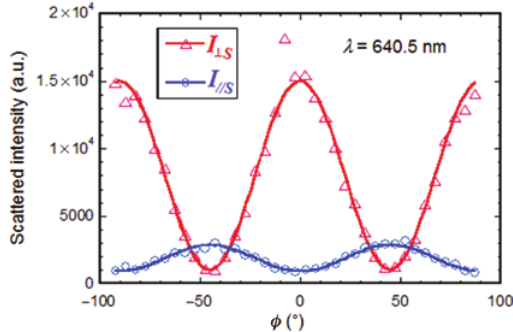
Figure 5: Example shown at l = 640.5 nm of the signal scattered by sample S3-C along the two output polarization channels I perpendicular and parallel to the scattering plane, respectively. Solid lines are a fit to cos 2 φ and sin 2 φ